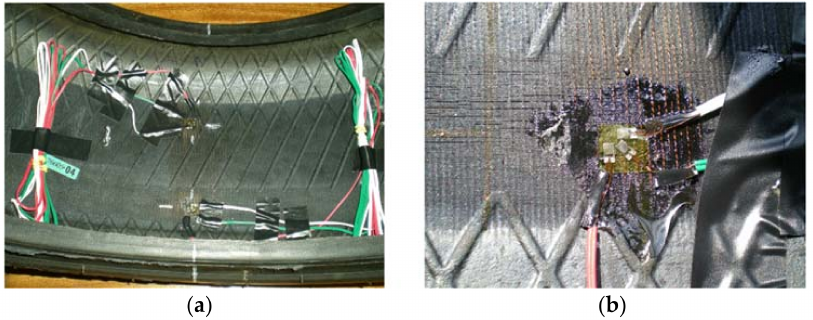
Figure 4. ( a ) Strain gauges’ setup; ( b ) Multiaxial gage example.